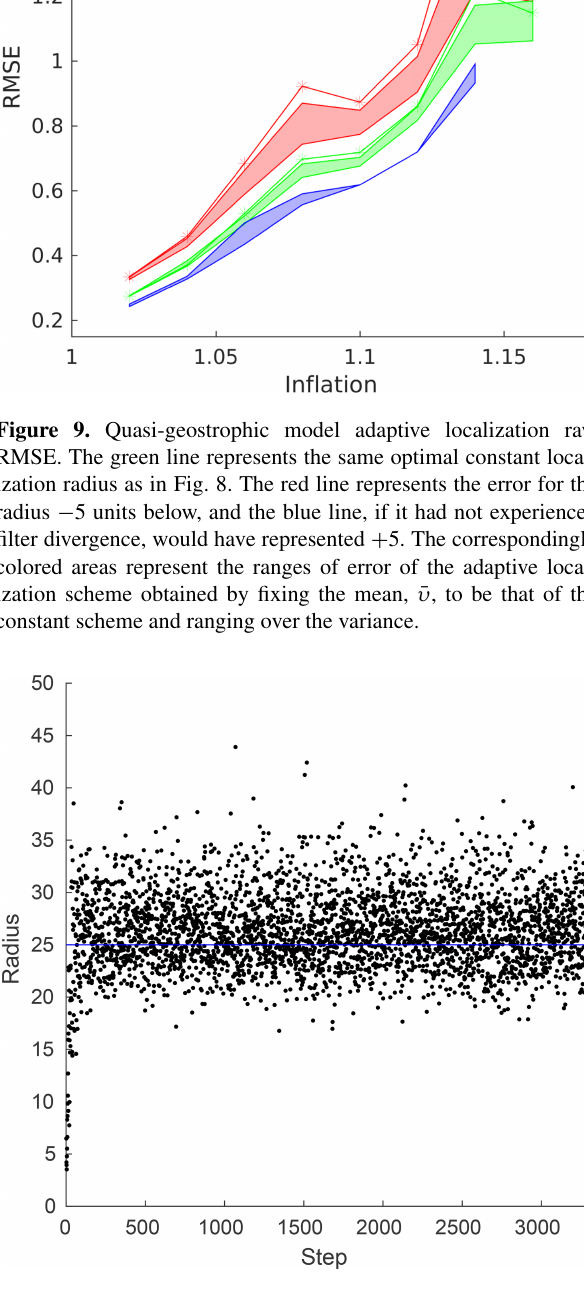
Figure 10. QGSO sample radii. For the configuration in Fig. 8 with α = 1 . 08, ¯ υ = 25, and Var (υ) = 4. Each dot represents a radius, with the line representing the